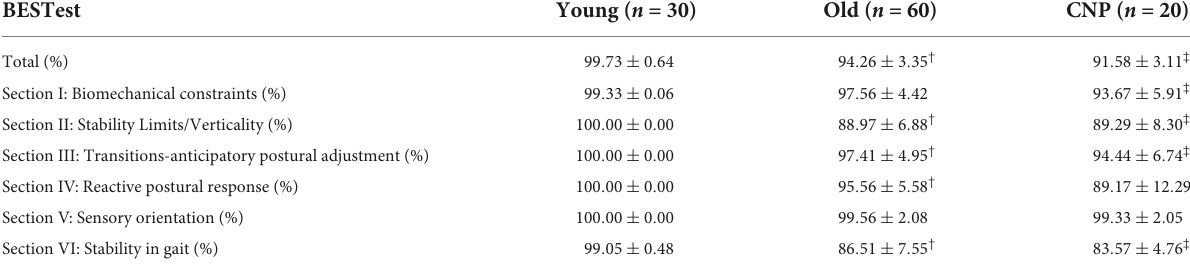
TABLE 2 Percentage score in total and each section of the